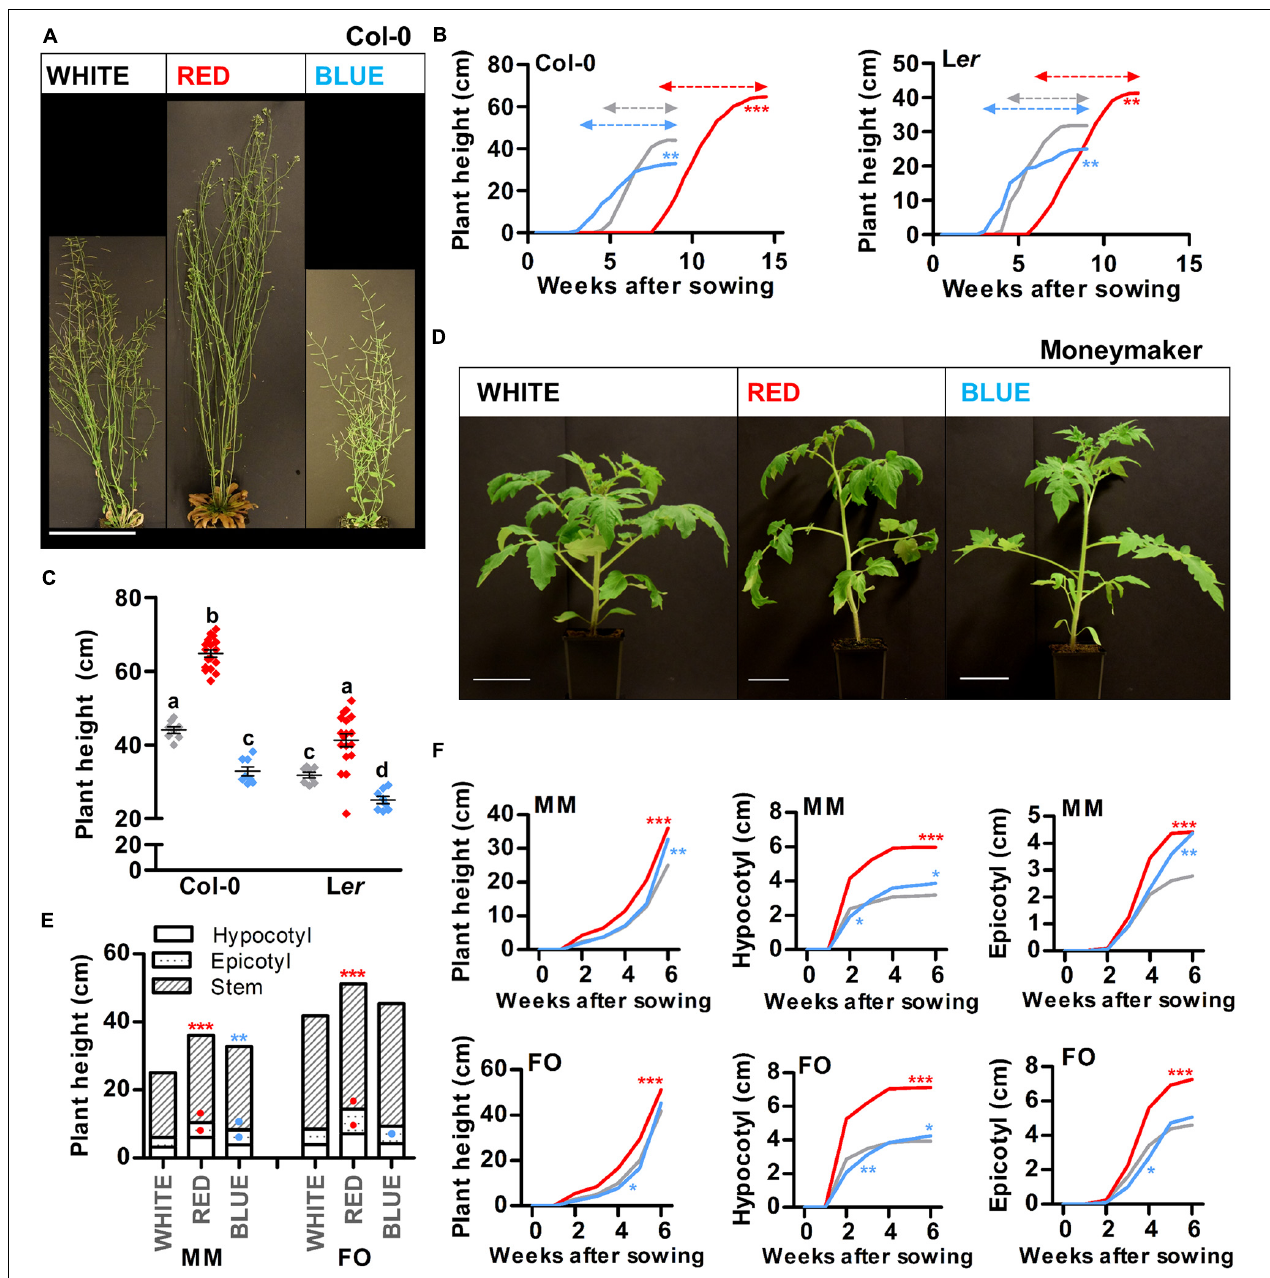
FIGURE 2 | Red light promotes shoot growth in Arabidopsis and young tomato plants. (A) Representative Arabidopsis Columbia (Col-0) plants grown in white, red, or blue LED conditions until 4 weeks after bolting. (B,C) Quantification of the plant height over time (B) or the plant height after termination of the primary inflorescence (C) of Arabidopsis Col-0 or Landsberg erecta (L er ) plants as shown in ( A and Supplementary Figure S4E ), respectively. (D) Representative tomato Moneymaker (MM) plants grown in white, red, or blue LED conditions until 45 days after sowing (DAS). (E,F) Quantification of the plant height at 45 DAS (E) , or the plant height, hypocotyl length, or epicotyl length over time (F) of tomato MM or Foundation (FO) plants as shown in ( D and Supplementary Figure S5D ), respectively. LED conditions and ecotypes or cultivars were compared using a one-way ANOVA followed by a Tukey’s test (letters a–d indicate statistically significant differences, p < 0.05) in (C) . In (B,E,F) , monochromatic LED conditions (red or blue) were compared to white (control) using a two-sided Student’s t -test (asterisks indicate significant differences ( p < 0.05) in time series in (B,F) , or in plant height in (E) , bullets indicate significant differences ( p < 0.05) in hypocotyl or epicotyl length in (E) . Error bars represent standard error of the mean in (C), standard errors for (B,E,F) are listed in Supplementary Table S2 ( n = 20). Dashed arrows in (B) represent the time from bolting until termination of the primary inflorescence. For presentation purposes, pots were placed in front of a black background in (A,D) before photographing. Scale bars indicate 10 cm in (A) , and 5 cm in (D) . Similar results were obtained in two independent experiments.